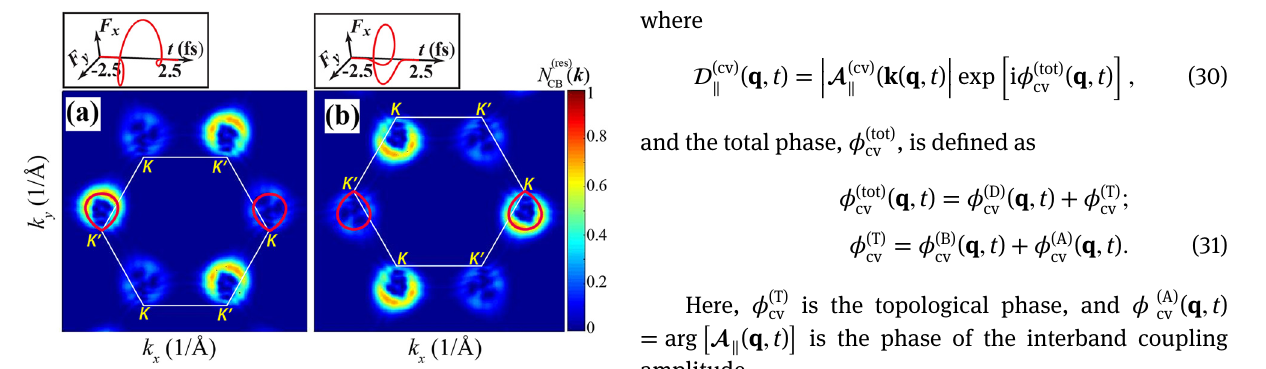
( k ) for GG with the band gap Figure 2: Residual CB population N (res) CB of 2 eV in the extended zone picture after a chiral single-cycle excitation pulse. (a) The excitation optical pulse is left-handed with = 0 . 5 V ̊ A − 1 . Inset: Waveform of the pulse the amplitude of F 0 F ( t ) = { F x ( t ) , F y ( t ) } as a function of time t . (b) The excitation optical = 0 . 5 V ̊ A − 1 . Inset: pulse is right-handed with the amplitude of F 0 Waveform of the pulse as a function of time t . The solid white lines show the boundary of the first Brillouin zone with the K , K ′ points indicated. The separatrix (Eq. (6)) is shown in panels (a) and (b) by red solid